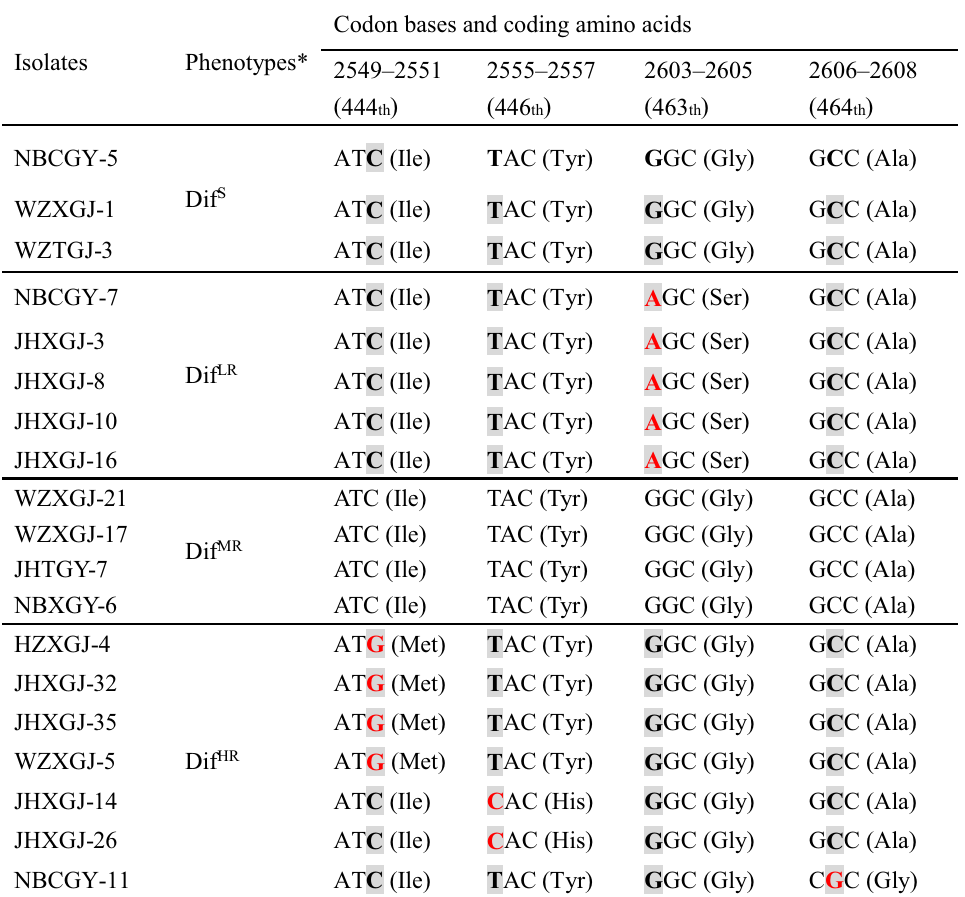
Table 3 Comparison of the cyp51 gene and amino acid sequences between Dif S and Dif